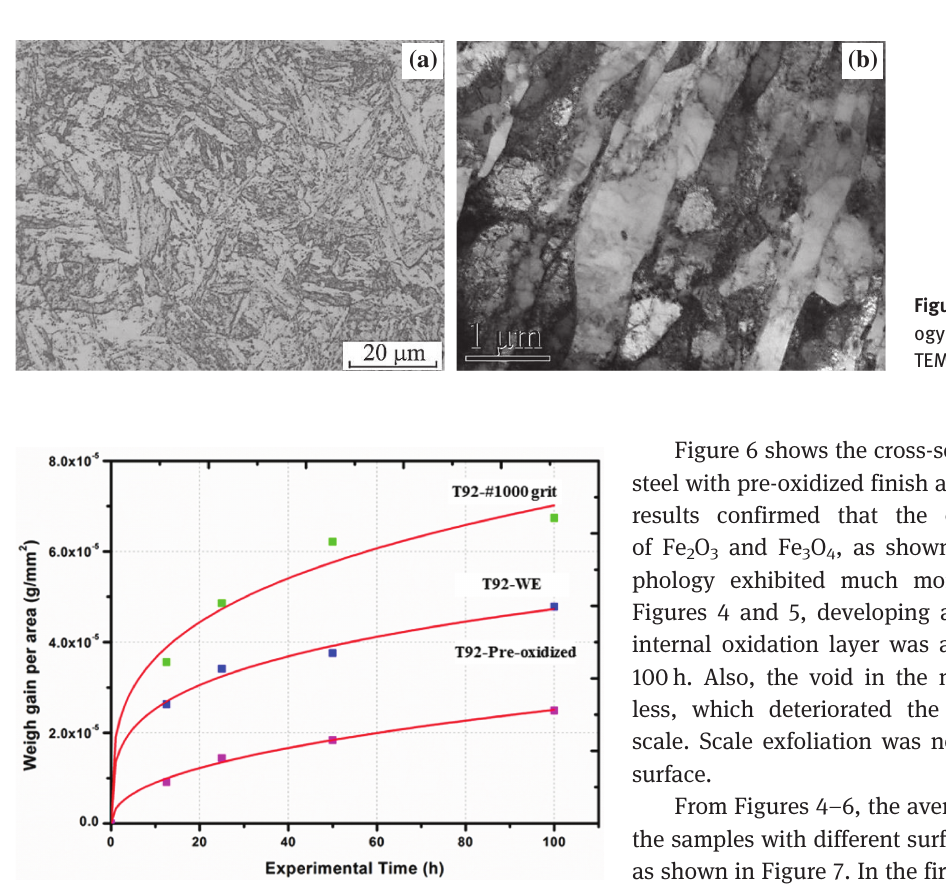
Table 2: Power rate coefficients k n.